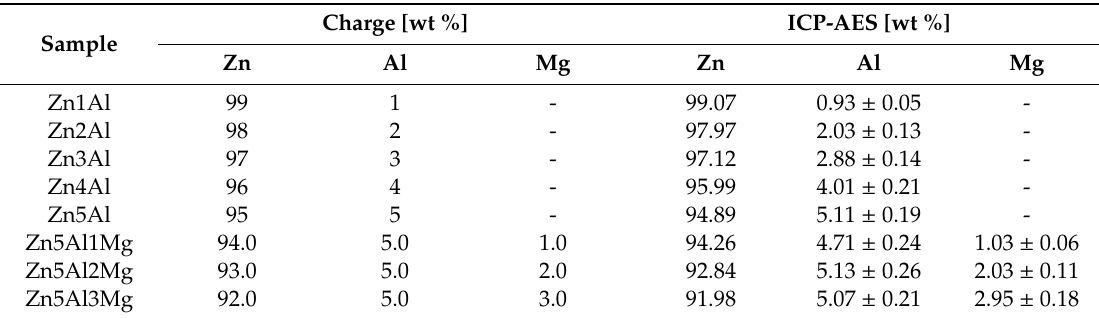
Table 1. Composition of Zn–Al and Zn–Al–Mg alloys and the results of chemical analysis by